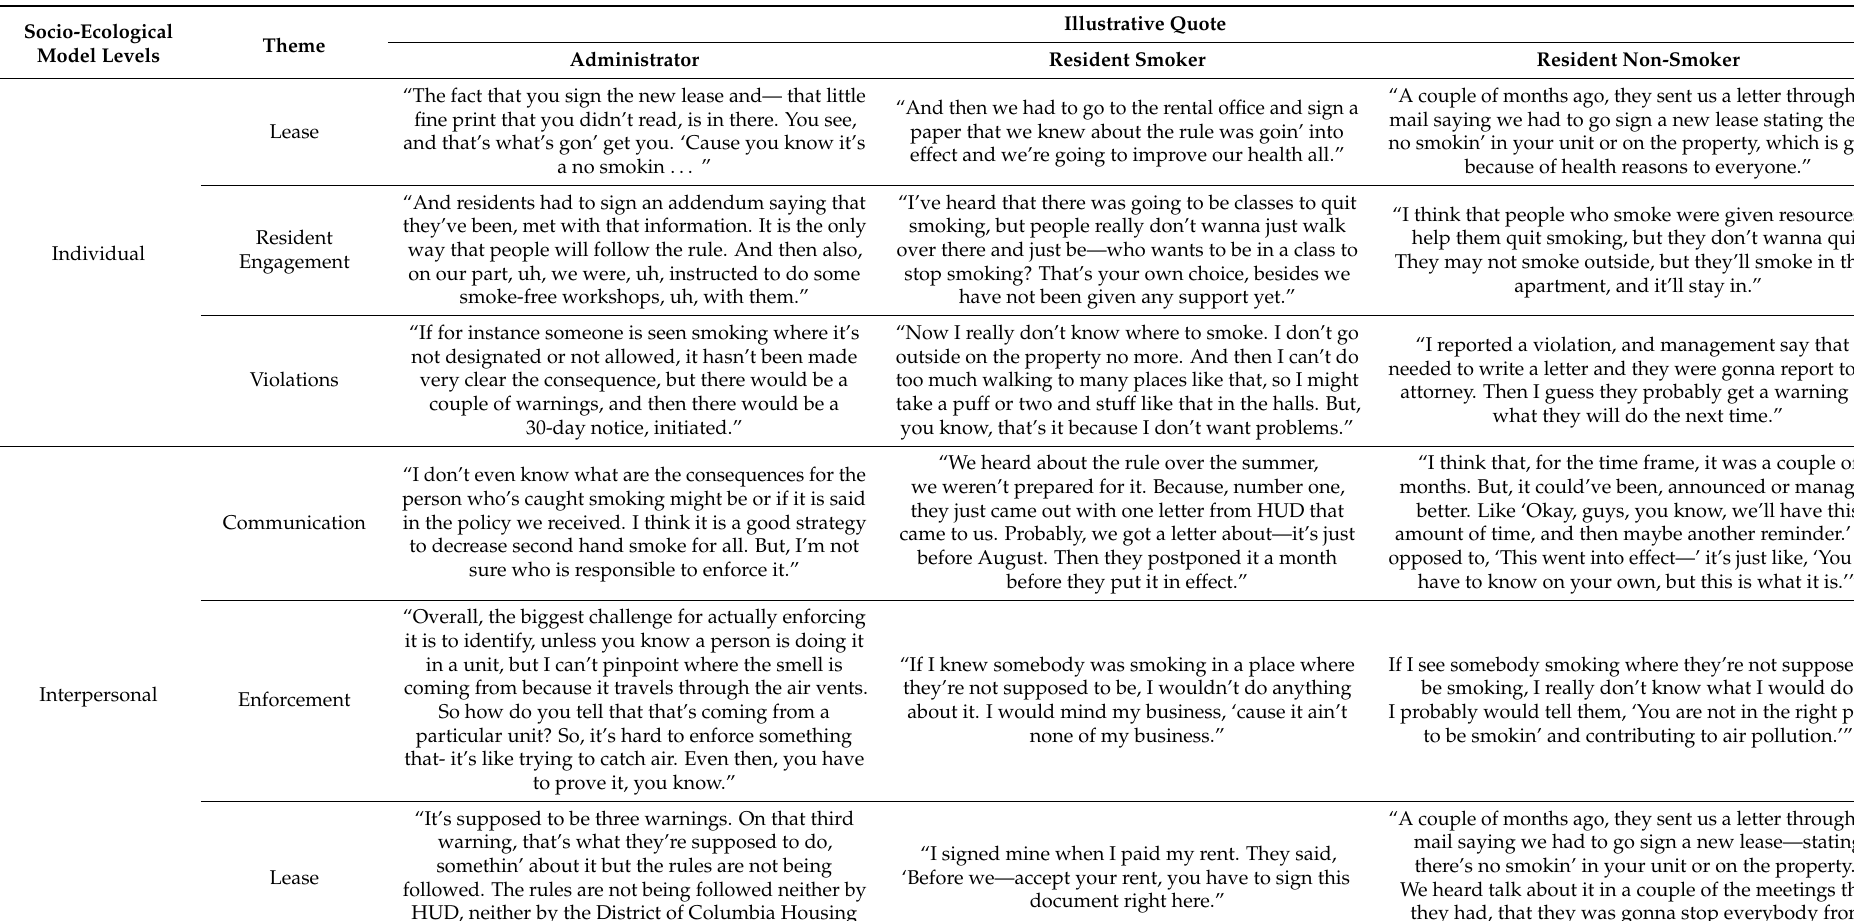
Table 4. Illustrative quotes of major themes at each level of socio-ecological